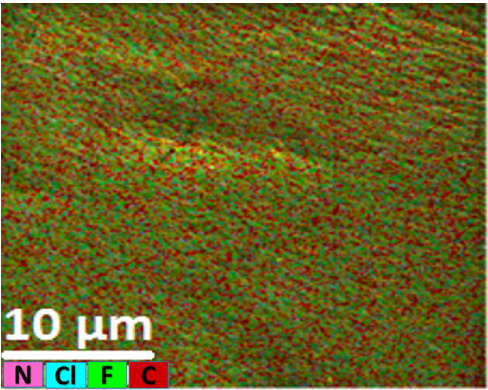
Figure 12. EDS-layered image and compositional map of the optimized PIM (50 wt% PVDF-HFP, 40 wt% Aliquat ® 336 and 10 wt% DBP).